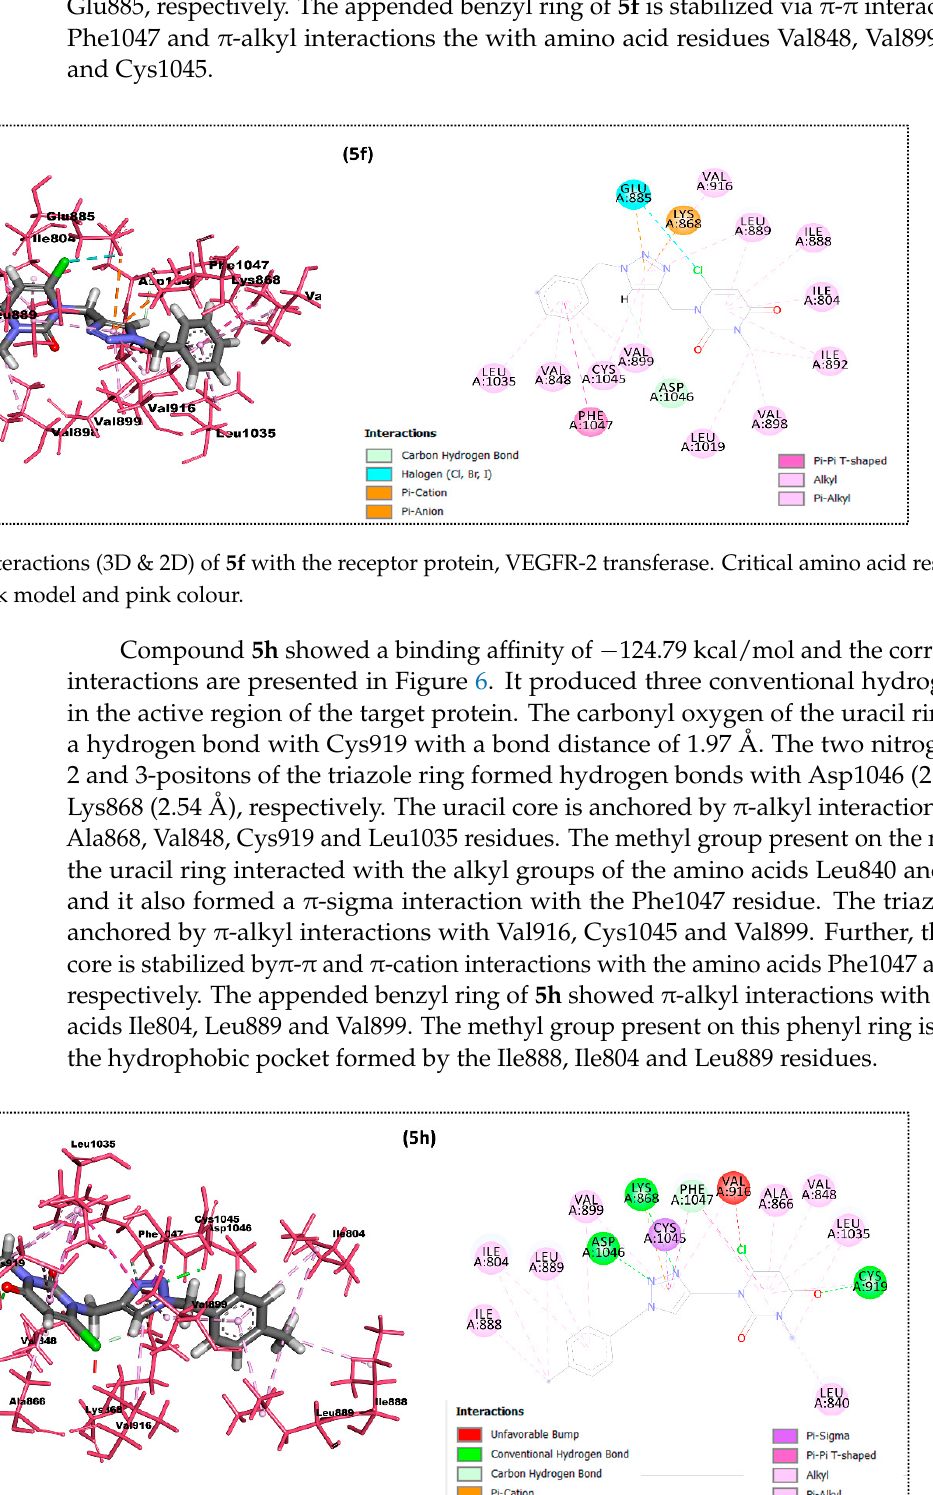
Figure 6. Docking interactions (3D & 2D) of 5h with the receptor protein, VEGFR-2 transferase. Critical amino acid residues are shown in the stick model and pink colour.